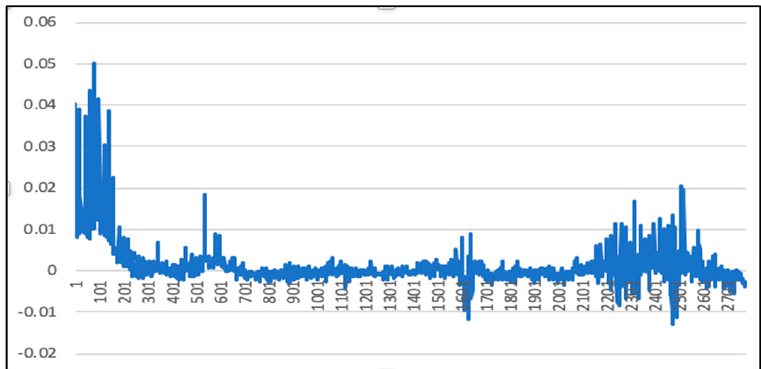
Figure 14. Error map of the LSTM prediction results and the actual results (8500th data to 11,300th data).